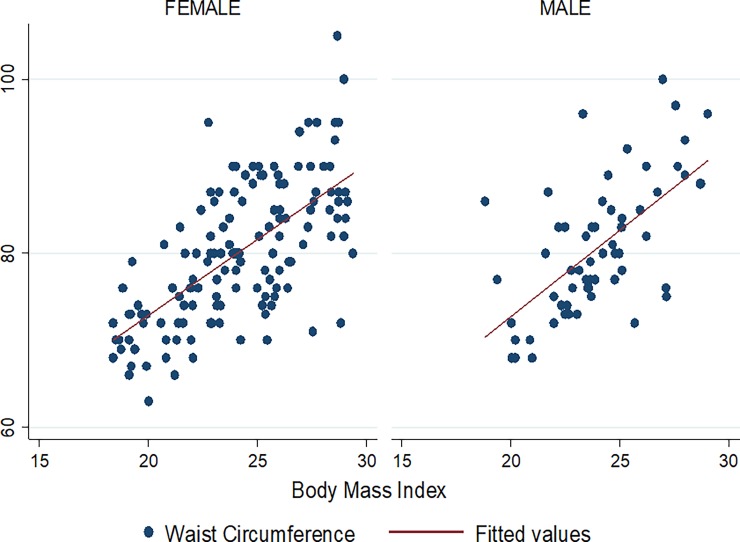
Linear regression model of the association between WC and BMI in females and males.